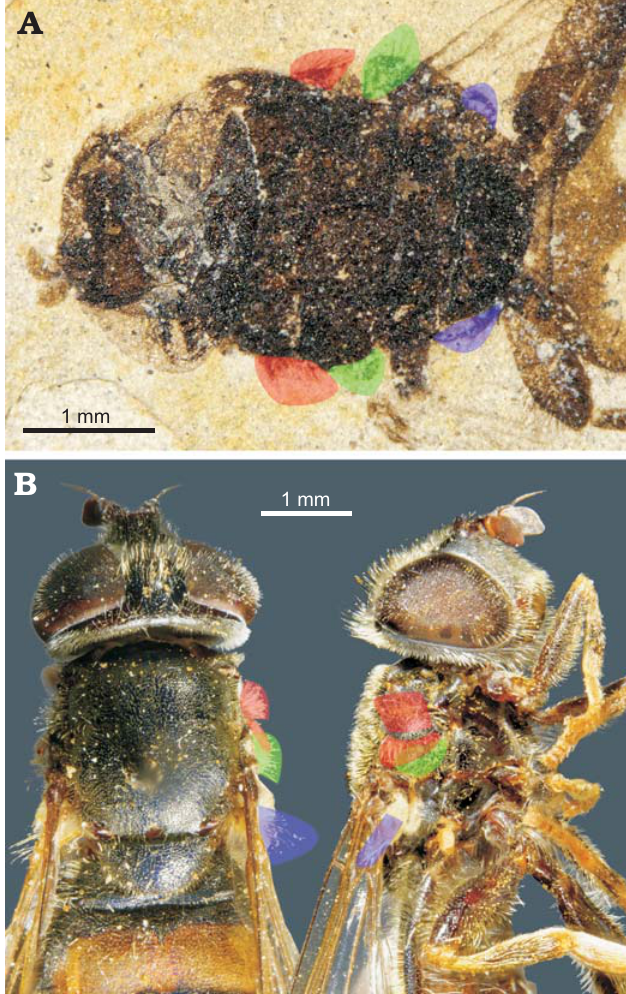
Fig. 4. Dorso-lateral pilosity of thoracic pleura of pipizine hoverflies. A . Oligo pipiza quadriguttata Nidergras, Hadrava, and Nel gen. et sp. nov., holotype RNGL-S01, Rupelian, Céreste, France. B . Extant Pipiza festiva Meigen, 1822. Red, posterior anepisternal setae; green, anepimeral setae; blue, calypter